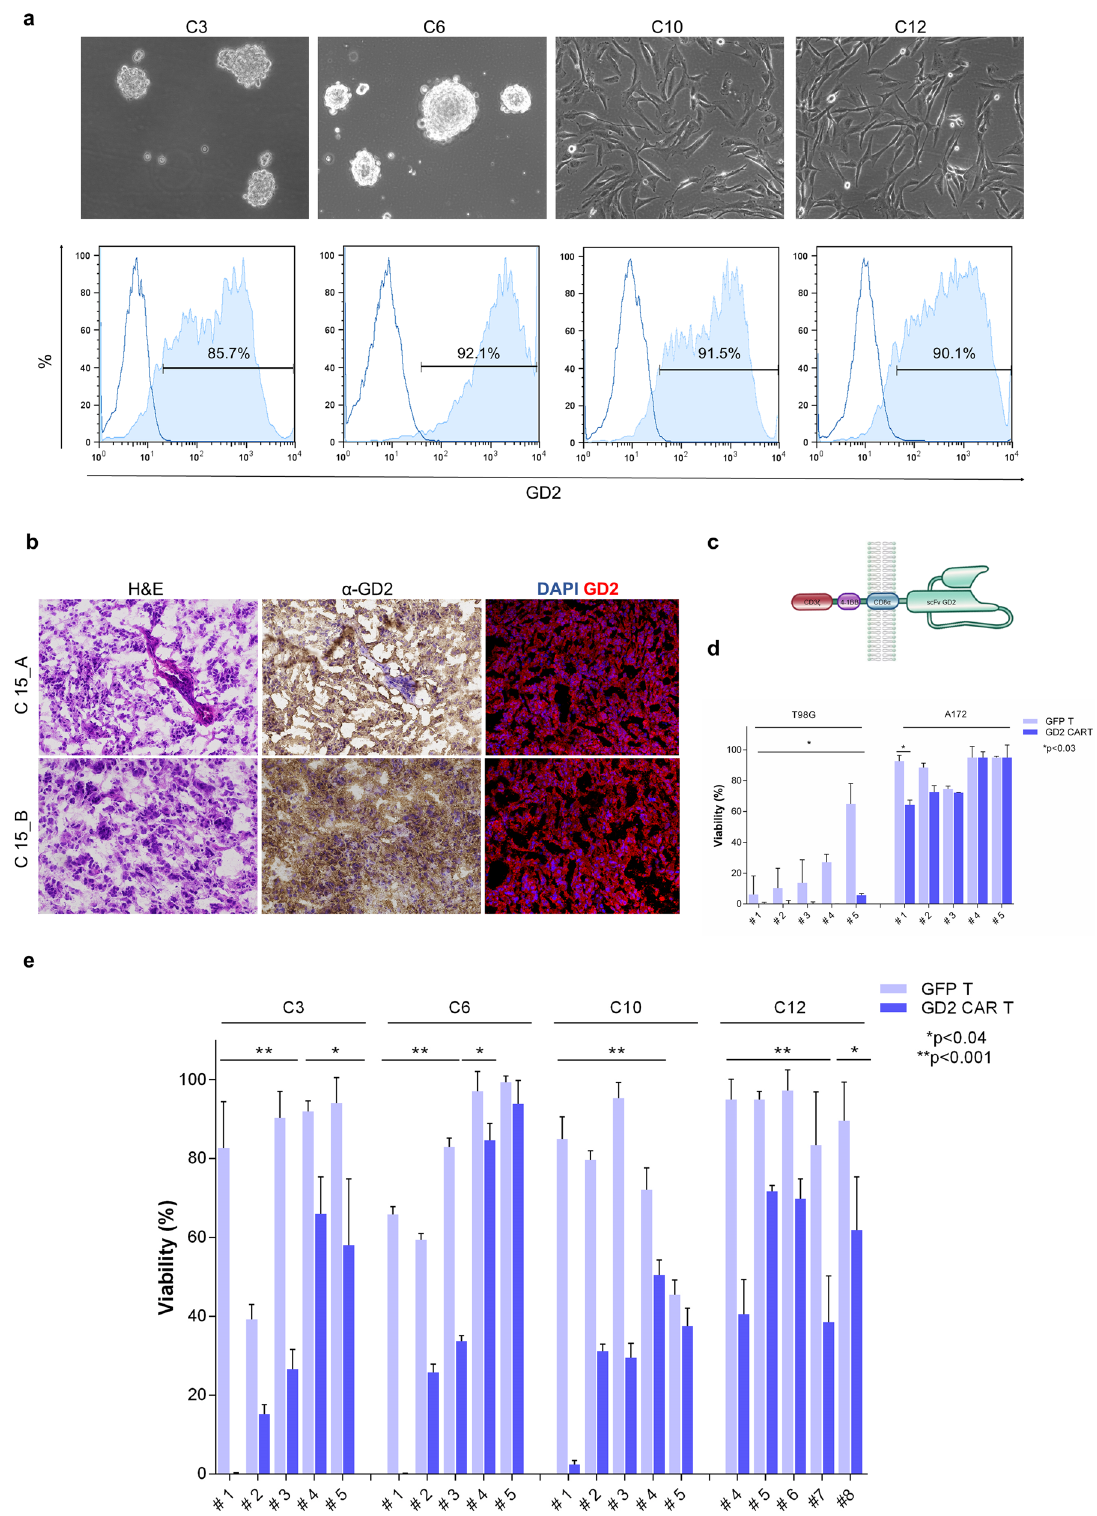
control (transduction ef fi ciency detected by GFP signal, 60 ± 10% and 75 ± 15%, respectively) were assessed over different periods, distinct co-culture conditions, and using different peripheral blood mononuclear cell (PBMC) donors to account for inter-donor variability as reported 17 , as well as targeting selected